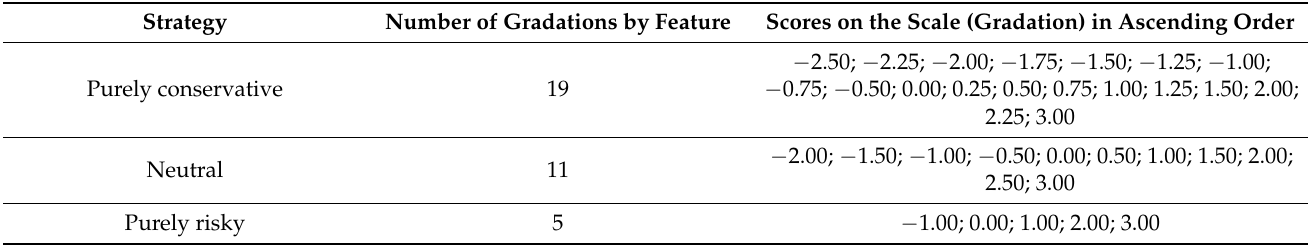
Table 1. Examples of features scales for purely conservative, neutral and purely risky assessment strategies. Strategy Number of Gradations by Feature Scores on the Scale (Gradation) in Ascending Order Purely conservative